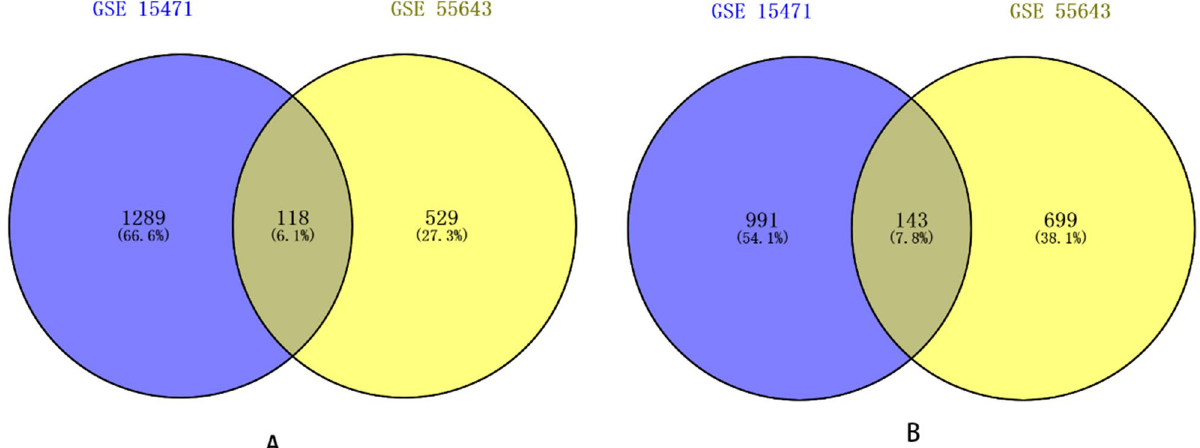
Figure 1. A Venn diagram showing the overlapping 261 DEGs in the two datasets (GSE15471 and GSE55643). ( a ) 118 up-regulated DEGs in the two datasets (log2FC > 1.2). ( b ) 143 down-regulated DEGs in two datasets (log2FC <